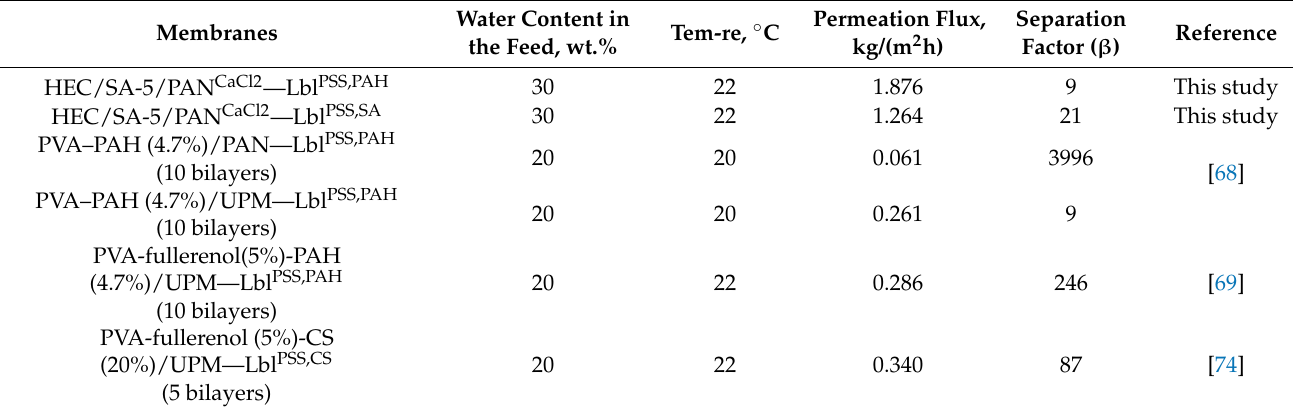
Table 9. The comparison of the transport properties of the membranes with the Lbl assembly surface modification in pervaporation dehydration of